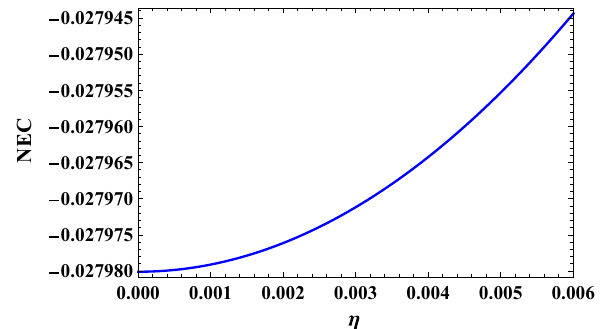
Fig. 9 NEC is shown at the radial distance r = 1 . 5 kpc with respect to the Global Monopole Charge η corresponding to the parameters ρ 0 = 0 . 004 kpc − 2 , alpha = 0 . 5 , β = 0 . 8 , r th = 1 kpc ,τ = 2 . 5 and